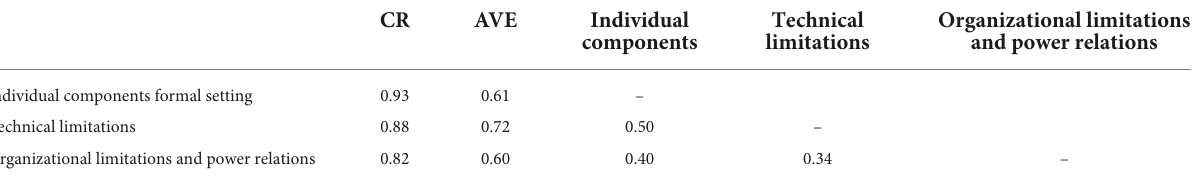
TABLE 4 Measuring barriers to formal